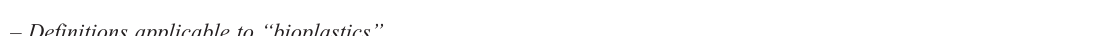
Table 1 – Definitions applicable to